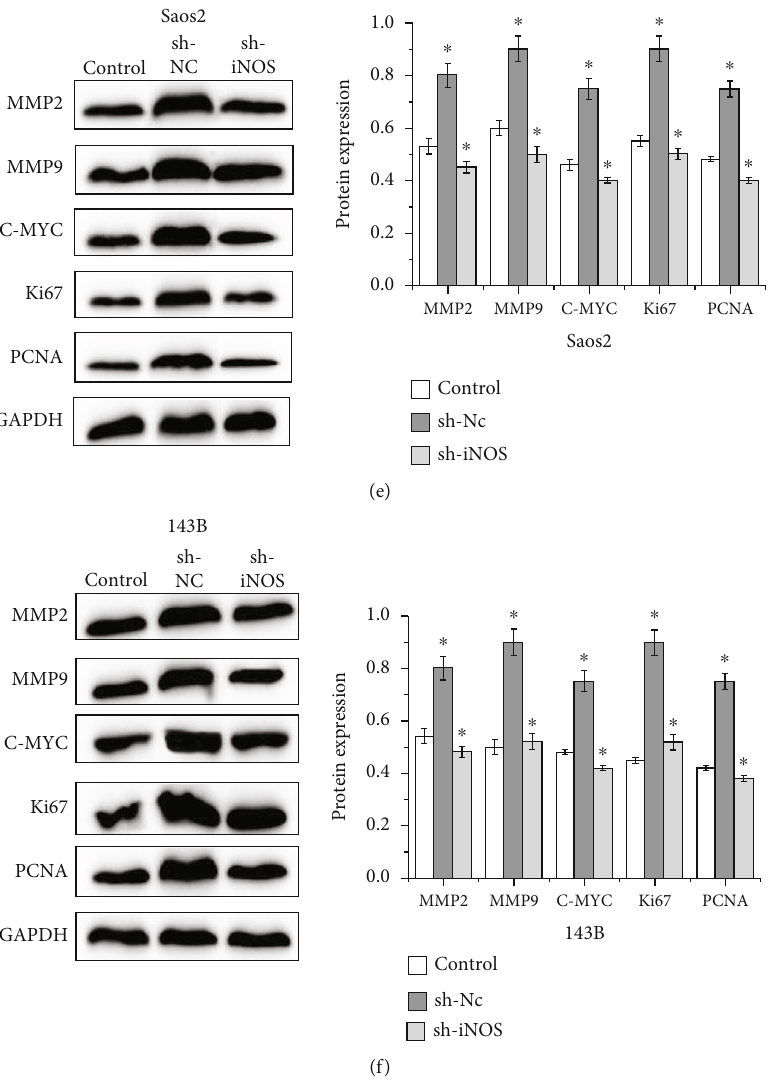
Figure 2: iNOS promotes OS cells proliferation, migration, and invasion and inhibits OS cells apoptosis. (a) The proliferation abilities of Saos2 and 143B cells treated with iNOS inhibition by colony formation assay ( ∗∗ p < 0 : 01 ). (b) The proliferation abilities of Saos2 and 143B cells treated with iNOS inhibition by BrdU assay ( ∗ p < 0 : 05 ). (c) The migration and invasion abilities of Saos2 and 143B cells treated with iNOS inhibition ( ∗ p < 0 : 05 ). (d) The apoptosis abilities of Saos2 and 143B cells treated with iNOS inhibition ( ∗ p < 0 : 05 ). (e, f) The expressions of MMP2, MMP9, C-MYC, Ki67, and PCNA in Saos2 and 143B cells treated with iNOS